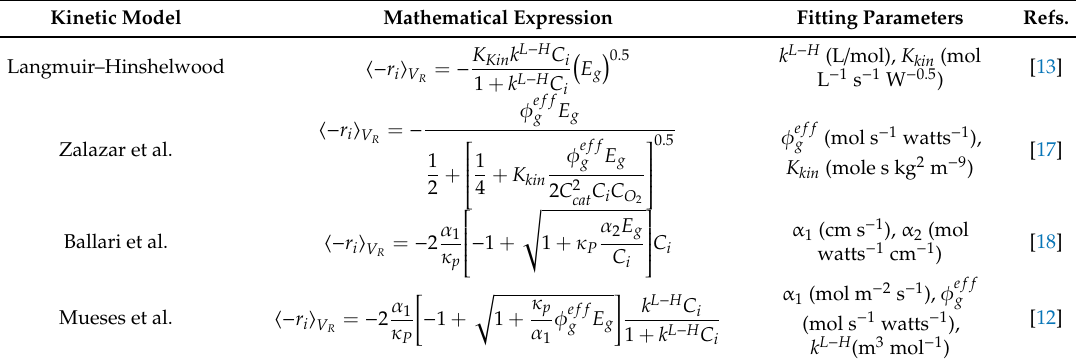
Table 2. Photocatalytic kinetic models in